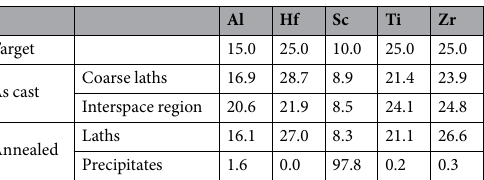
for other HEAs 48 . The dominant contribution to the Gibbs energy difference comes from the configurational entropy (blue shaded area). The reason is that the configurational entropy is considerably smaller for the D0 19 phase, because the Al atoms are confined to the Al sublattice in contrast to the hcp A3 phase where the Al atoms can be located on any of the hcp lattice sites. Therefore, the stability of the disordered hcp A3 phase is more and more increased as temperature rises, leading eventually to a phase transition from D0 19 to A3. Averaging over both SQS supercells for each phase gives a transition temperature of about 1230 K. Note that by assuming an ideal entropy [Eqs (5–11)] and neglecting short-range order, the predicted order-disorder temperature is likely under- estimated 48, 49 . Considering the variation in the energies of the SQS supercells (Fig. 4b) provides in fact a temper- ature window of 1100 … 1350 K for a possible transition as indicated by the gray diagonal stripes in Fig. 4c. The